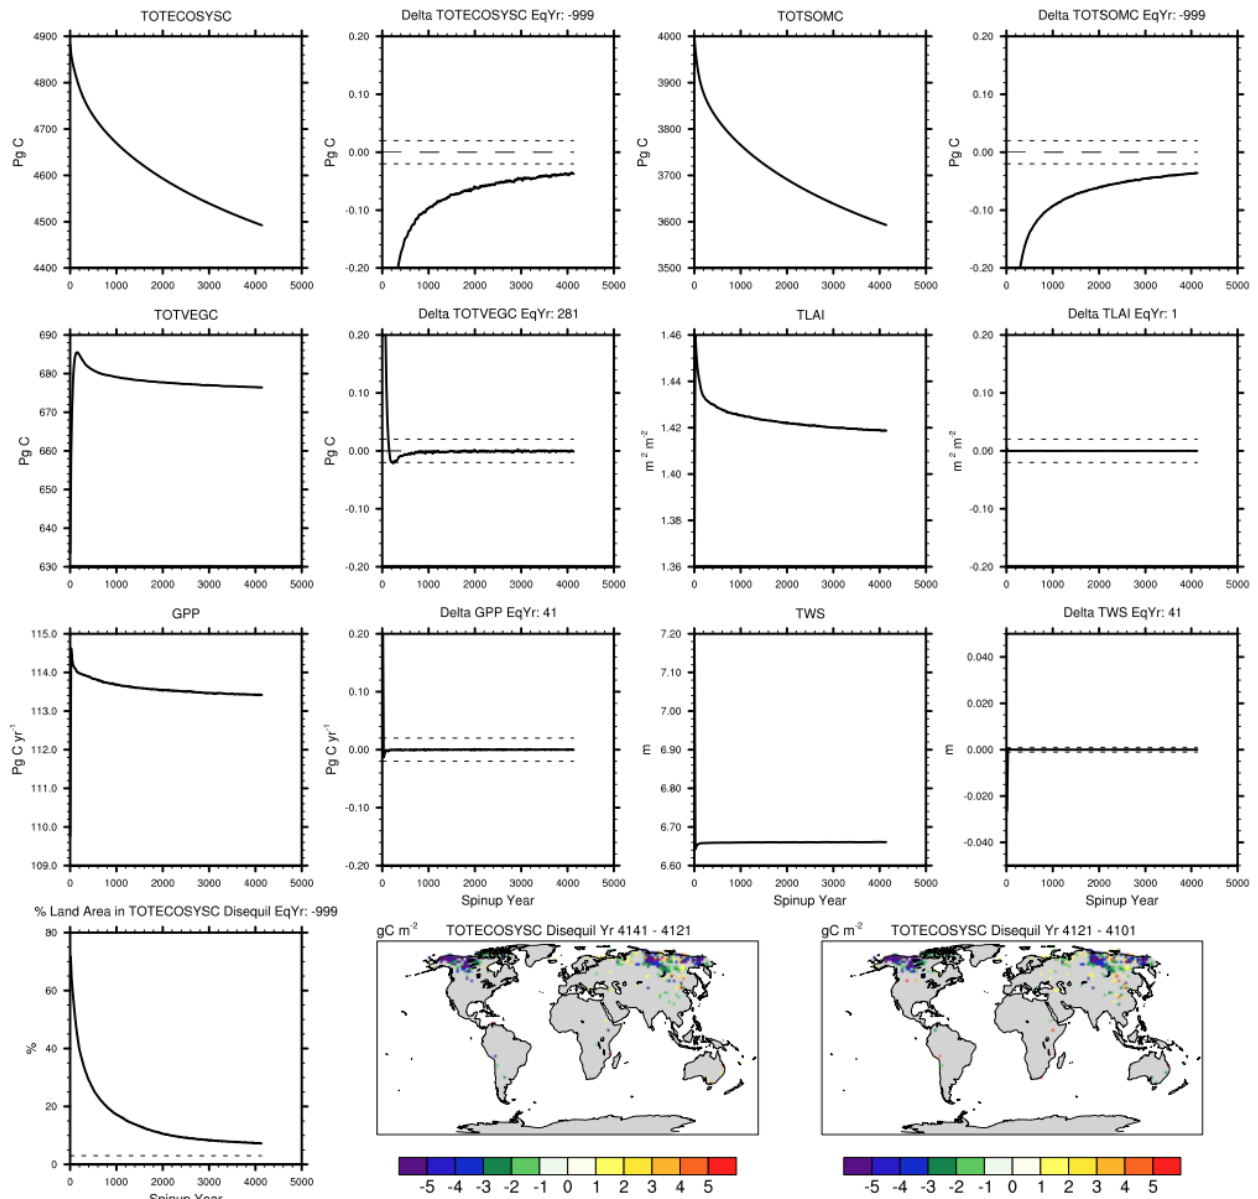
Figure A1. Evolution of land carbon fields in land-only spin-up simulation: total ecosystem carbon (TOTECOSYSC), total soil organic matter carbon (TOTSOMC), total vegetation carbon (TOTVEGC), total leaf area index (TLAI), gross primary productivity (GPP), and terrestrial water storage (TWS). Fields are plotted both as raw global average time series as well as “delta” time series that show the running difference between consecutive 20-year averages. The latter show that TOTSOMC dominates TOTECOSYSC and is the slowest term to equilibrate but has reached a reasonable delta value of around − 0.04PgC after 4000 years of spin-up. The plots in the bottom row show that less than 10% of global land area remains outside of the target delta range for TOTECOSYSC (shown as dashed lines in the delta plots) and that the regions associated with slight disequilibrium at the end of spin-up are concentrated in northern